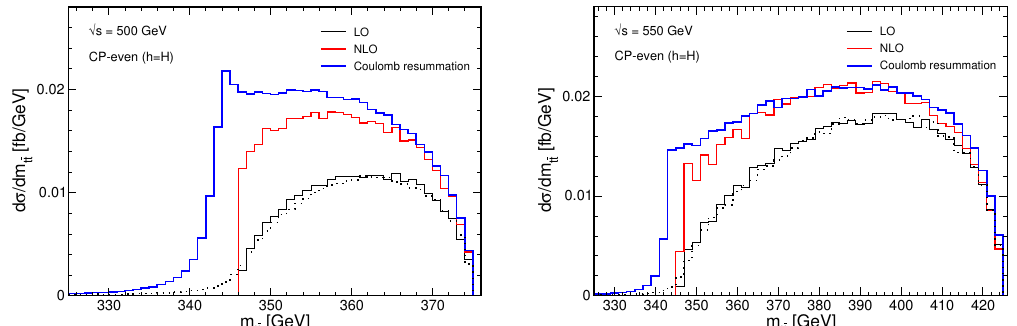
Figure 7 . m t (cid:22) t distribution for the pure scalar case ( h = H ) at p s = 500 GeV and 550 GeV. Black solid and red solid lines are the LO and NLO cross sections for the on-shell t (cid:22) t , respectively, and black dotted and blue solid lines are the Born-level and the Coulomb-resummed cross sections with top-quark o(cid:11)-shellness, respectively.